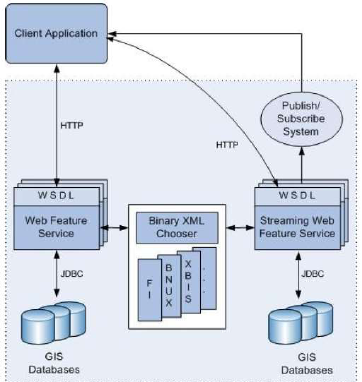
Figure 1. The SDI framework supporting real time data grid incorporating binary XML framework (Galip,